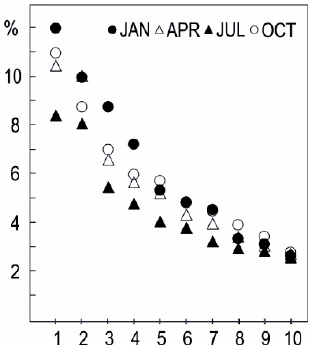
Figure 3. Amount of variance (%) explained by EOF modes 1–10 for selected months (1981–2015).